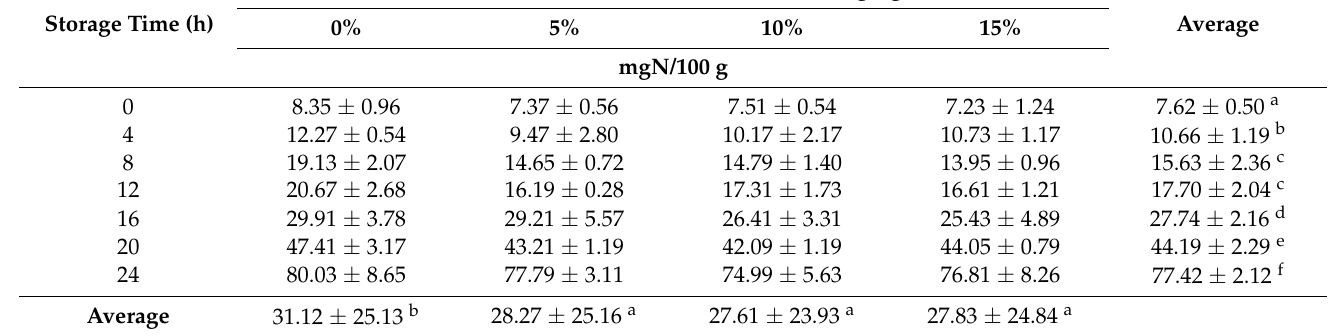
Table 2. Total volatile basic nitrogen (TVBN) of the packed meat stored at room temperature for 24 h. Average Result of Meat’s TVBN